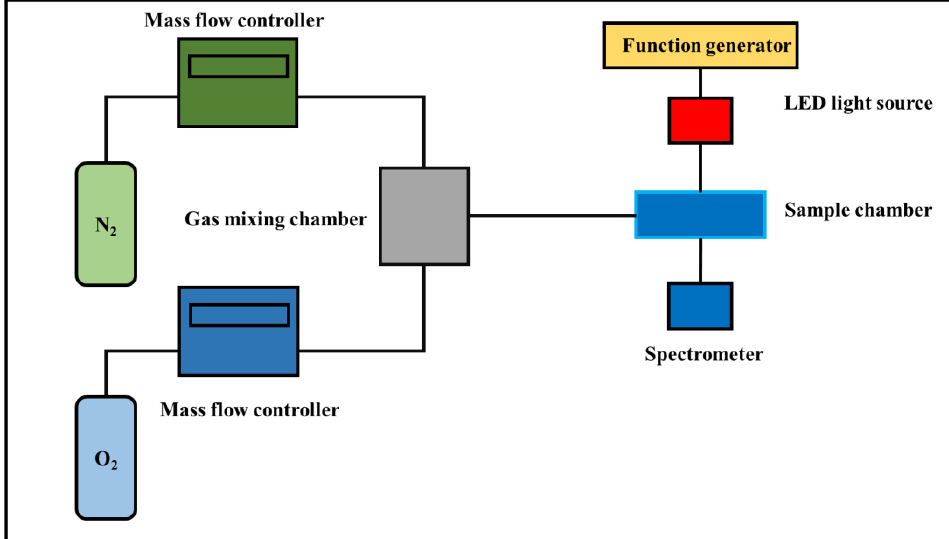
Figure 1. Schematic for optical gas sensing.